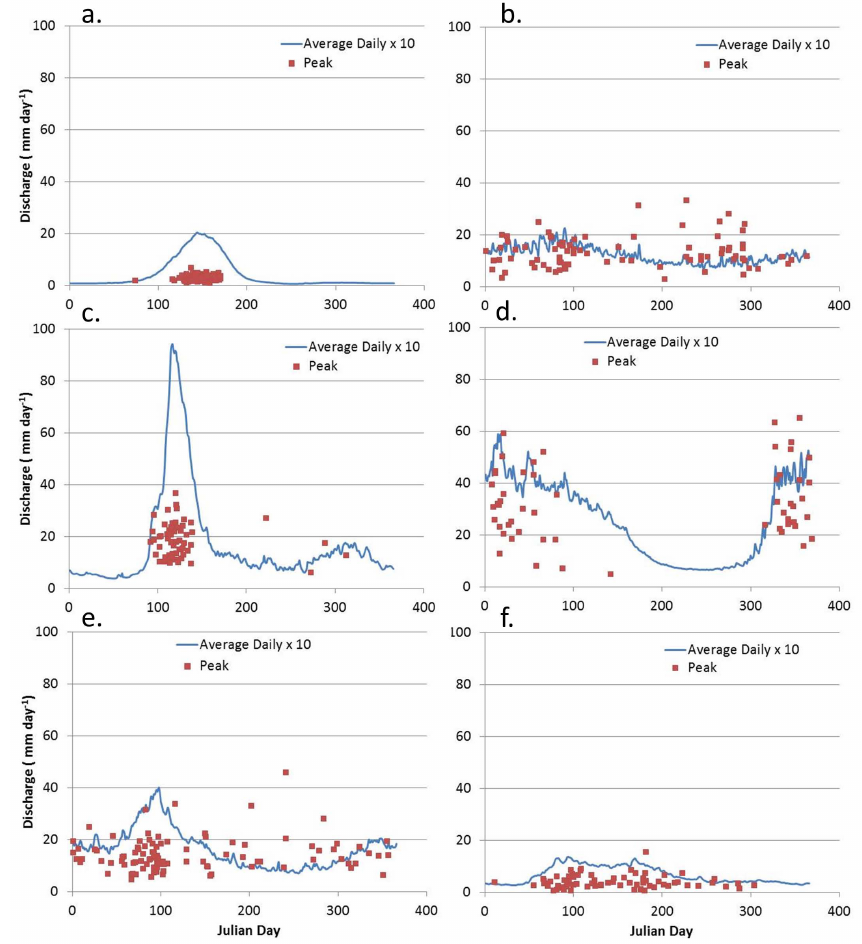
Fig. 2. Average daily discharge and peak annual discharge plotted against Julian Day for watersheds in varying hydroclimatological regions across the US (a) Yampa River, CO; (b) Yadkin River, NC; (c) St. John River, ME; (d) Umpqua River, OR.; (e) Delaware River, NJ; and the (f) Cedar River, IA. Note, as a point of reference, Julian day 122 corresponds to 1 May and Julian day 275 corresponds to 1